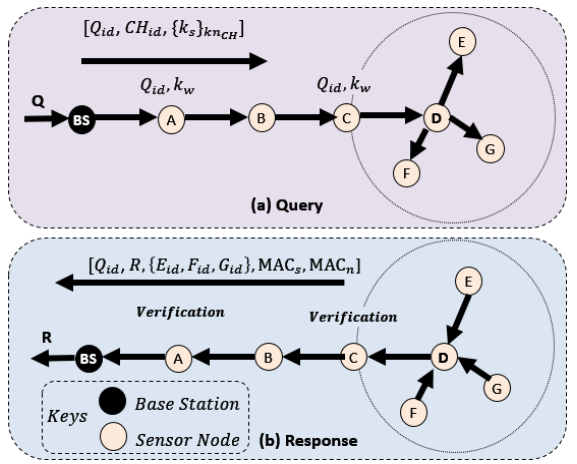
Figure 2. Query-response model for en-route filtering